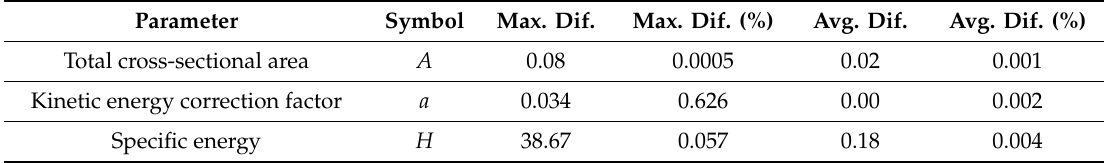
Table 2. Comparison analysis results for 2251 elevations (Di ff erences in computed hydraulic